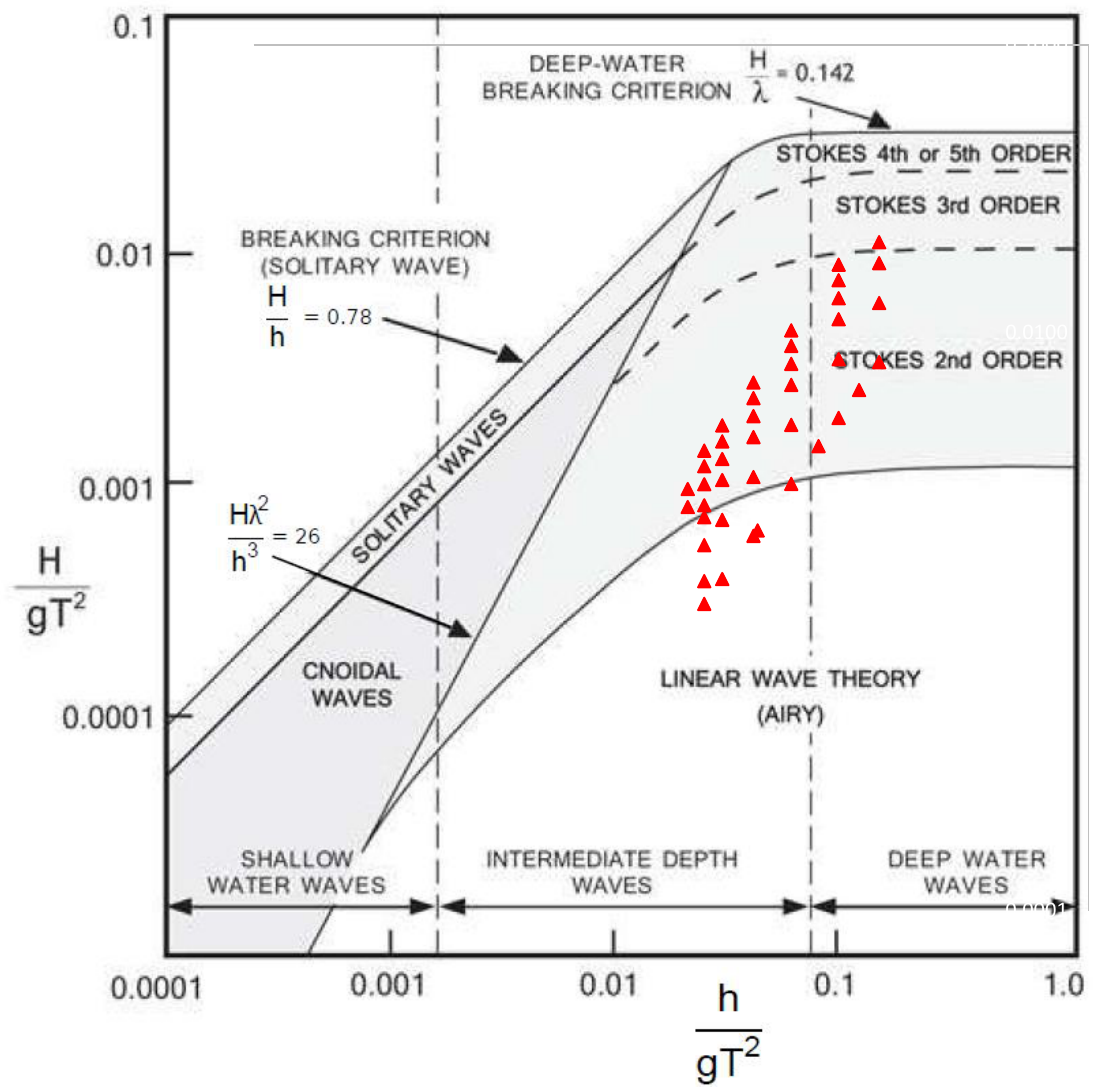
Figure 10. Diagram of applicability of di ff erent theories of water waves: Le-M é haut é [23]. The wave height H and the water depth d are normalized by gTˆ2, where g is the gravity acceleration and T is the wave